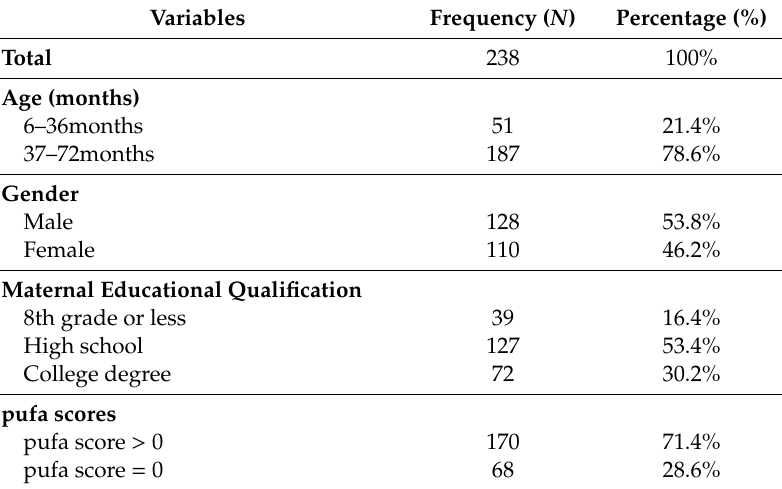
Table 1. Demographic details of the whole sample ( N = 238).